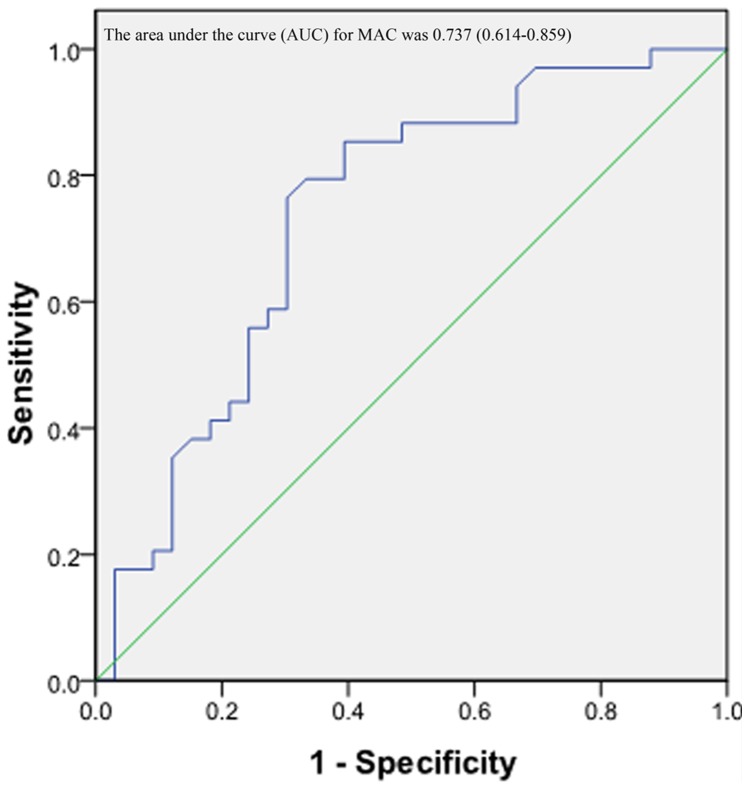
Receiver-operating characteristic (ROC) curve for mid arm circumference (MAC) in assessing nutritional and inflammatory status using malnutrition-inflammation score (MIS) as the reference standard (*P<0.05).For each screening test, sensitivity is plotted against 100-specificity. The ideal test would have 100% sensitivity and 100% specificity and reach the upper left corner of the graph; a test with no diagnosis value would lie along the diagonal between the lower left corner and the upper right corner.